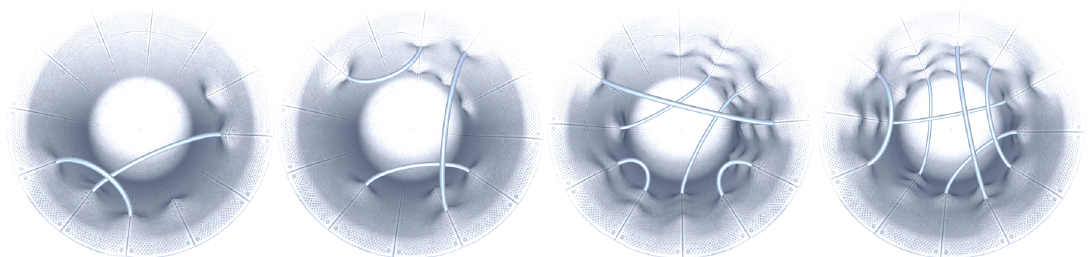
Figure 13. Randomly generated interiors with various degrees of